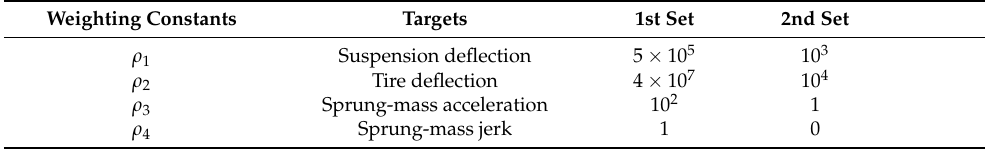
Table 1. Two types weighting factors used in performance